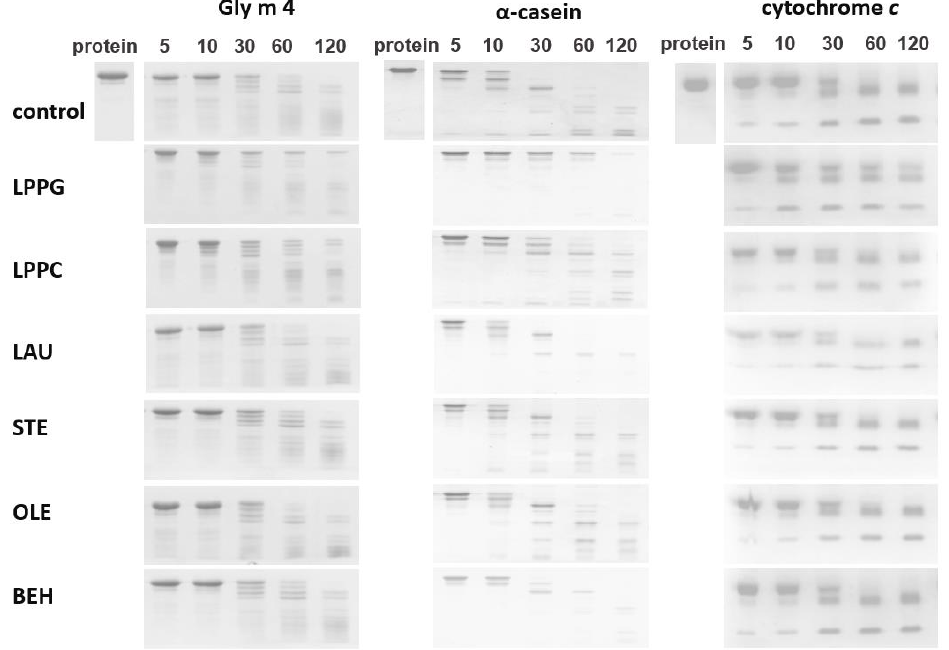
Figure 5. The effects of different lipids at concentrations of 0.2 mM on pepsin digestion of Gly m 4, α -casein or cytochrome c , at pH 2.0, as determined by SDS-PAGE (5, 10, 30, 60, and 120 — digestion time, min). Protein —Gly m 4, α -casein or cytochrome c without pepsin; pepsin digestion was per- formed at the pepsin-to- substrate mass ratio of 1:2000 for Gly m 4 and for α -casein or of 1:10000 for cytochrome c